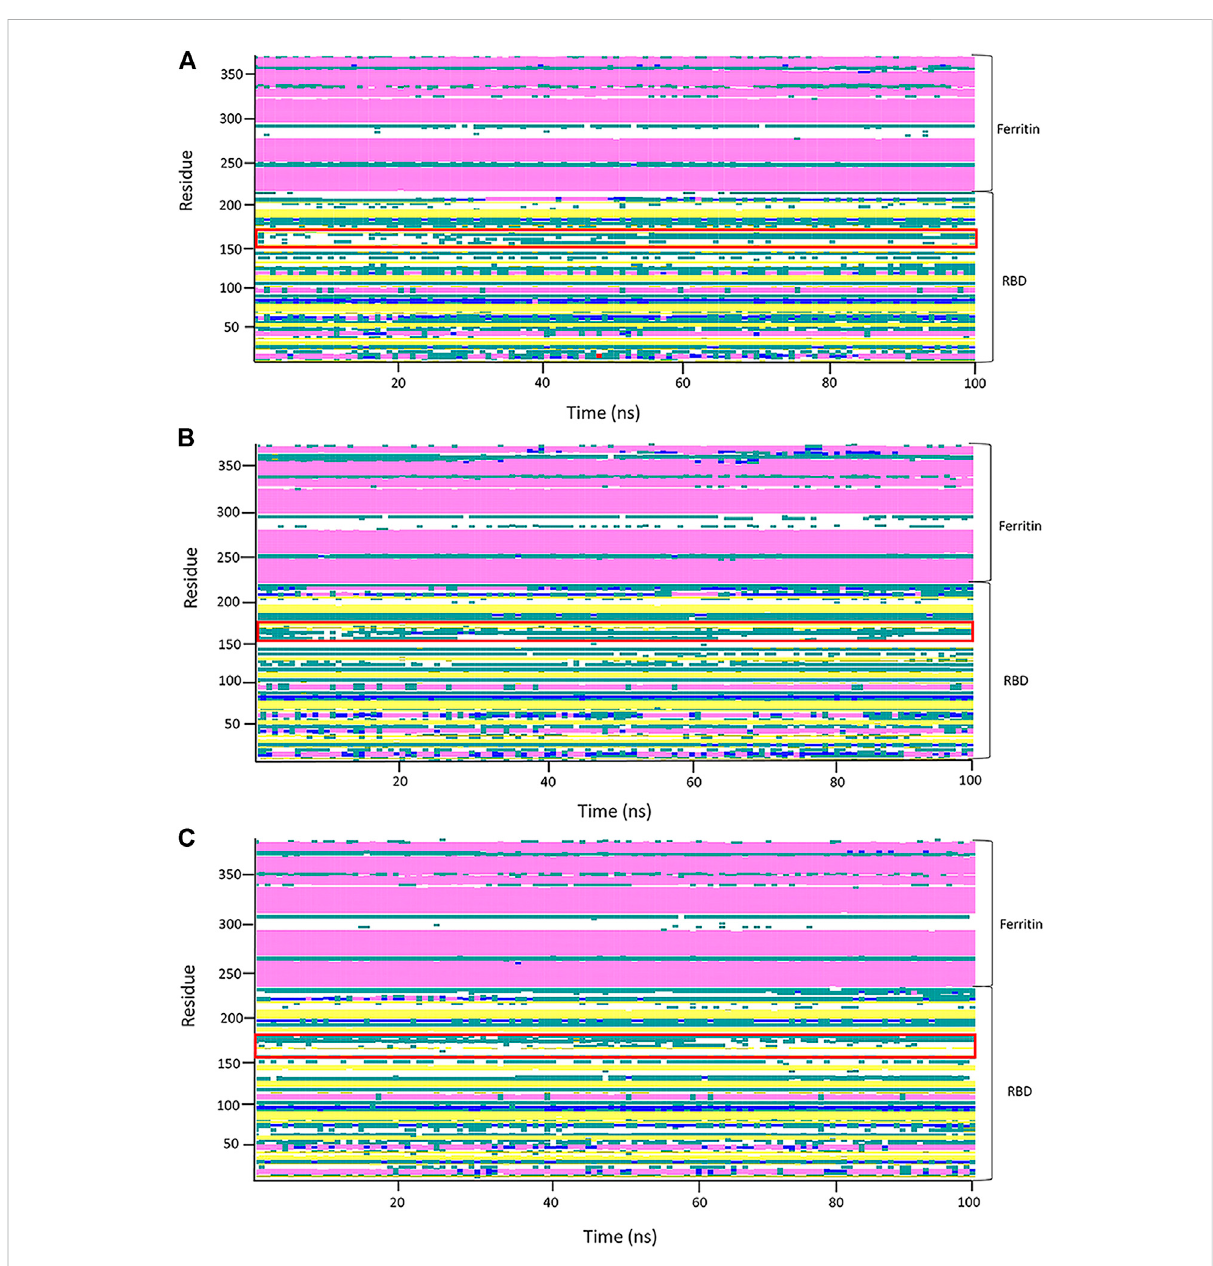
FIGURE 9 Analysisofthesecondarystructurethrough100nsofmoleculardynamics(MD)simulationofthe fi rstreplicatesofsystems.Secondarystructure analyses of the RBDfN, gRBDfN, and gmRBDfN systems are shown in (A) , (B) , and (C) , respectively. A fl exible loop of structures is shown within the red